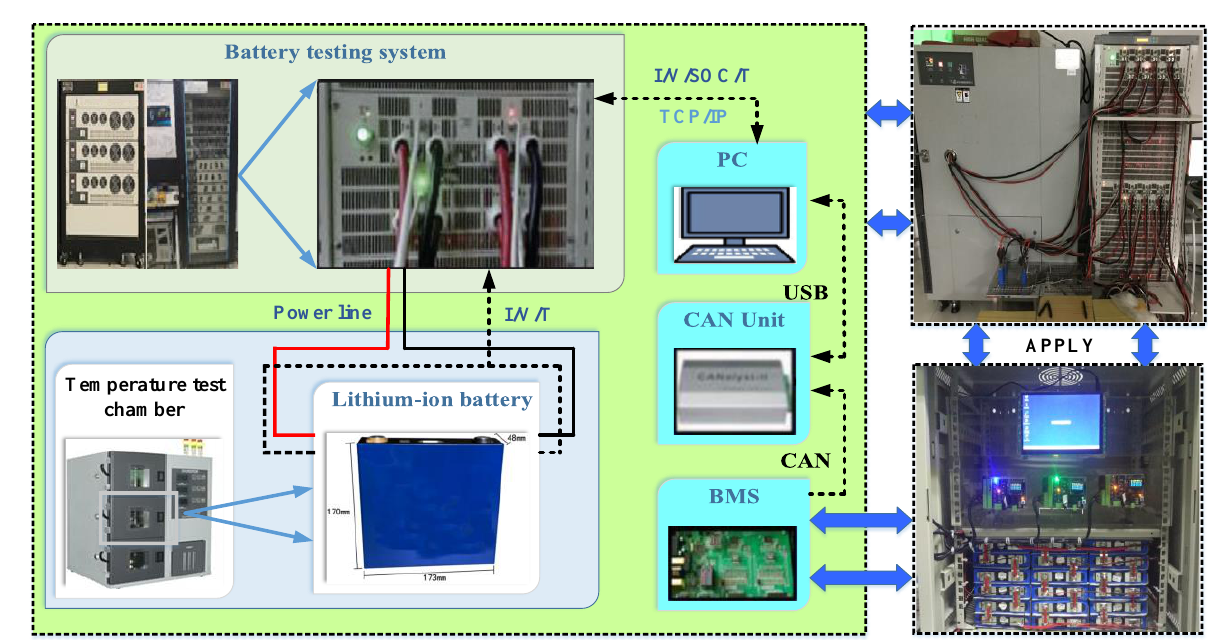
Figure 6. Battery test platform.